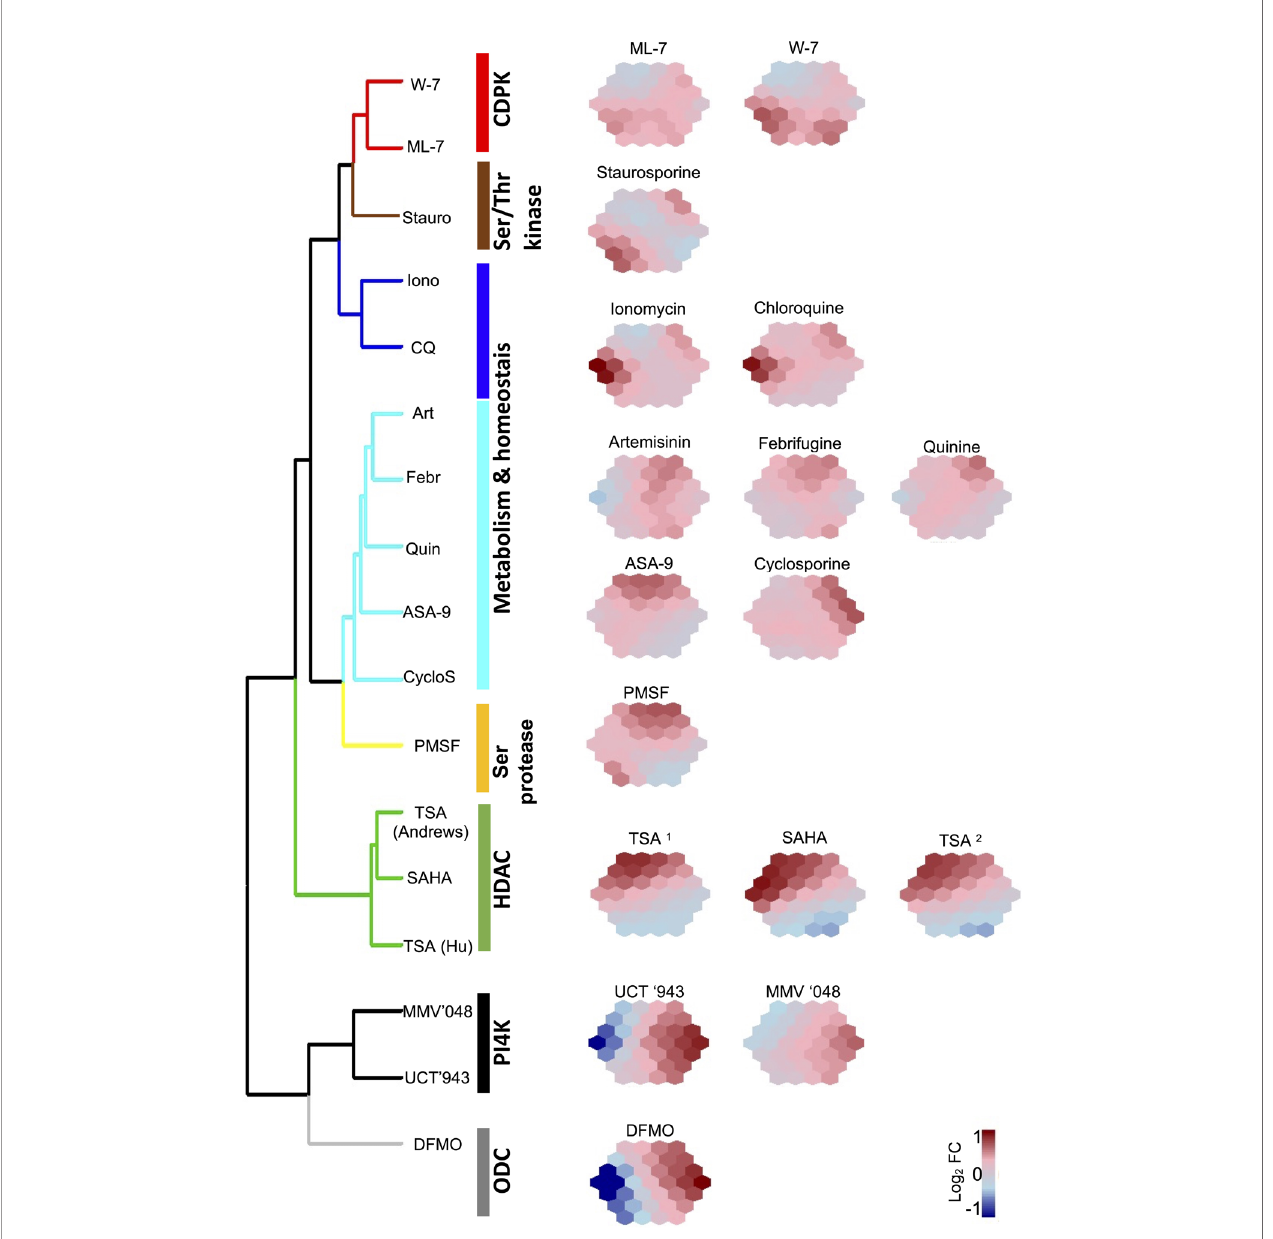
FIGURE 5 | The ML de fi ned biomarkers result in unique suprahexagonal chemo-transcriptomic fi ngerprints clustered per compound MoA. The dimensionality of expression pro fi les for the 50 biomarkers from various compound treatments were reduced using self-organizing maps (SOM) visualized as suprahexagonal chemo- transcriptomic fi ngerprints. Each hexagon within each suprahexagonal map de fi nes a cluster of biomarkers colored according to log 2 fold change (FC) expression values, and hierarchically clustered using Ward linkage on Euclidian distance of expression pro fi les. Known protein targets or biological processes affected by the compound treatments are indicated. CDPK, Ca 2+/ calmodulin-dependent protein kinase; Ser/Thr kinase, serine/threonine kinase; Ser protease, serine protease; HDAC, histone deacetylase; ODC, ornithine decarboxylase; Stauro, staurosporine; Iono, ionomycin; CQ, chloroquine; Art, artemisinin; Febr, febrifugine; Quin, quinine; ASA-9, 2-aminosuberic acid derivative; CylcoS, cyclosporine A; PMSF, phenylmethylsulfonyl fl uoride; TSA, trichostatin A; SAHA; suberoylanilide hydroxamic acid; DFMO, di fl uoromethylornithine; TSA1, data from Hu et al. (2009); TSA2, data from Andrews et al.